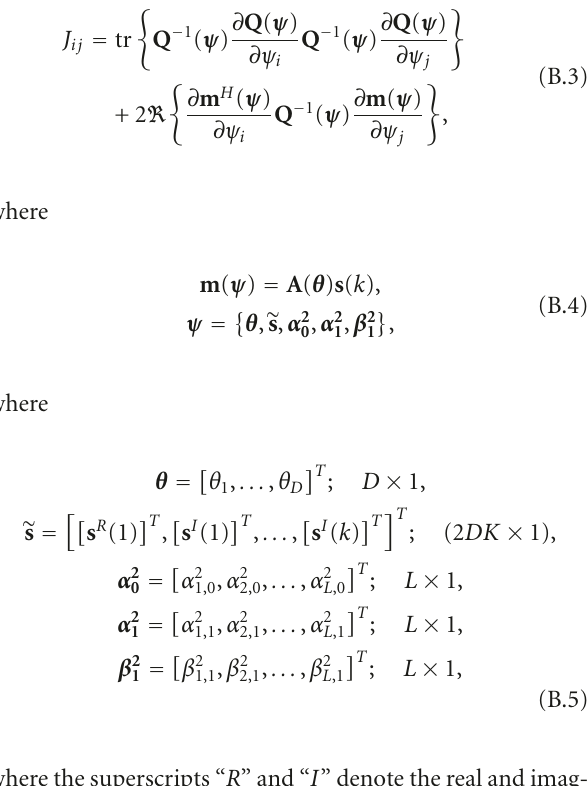
Figure 8: RMSE and CRB versus snapshots for deterministic maxi- mum likelihood (DML), music, and proposed method, two targets in measured underwater noise, SNR = 0